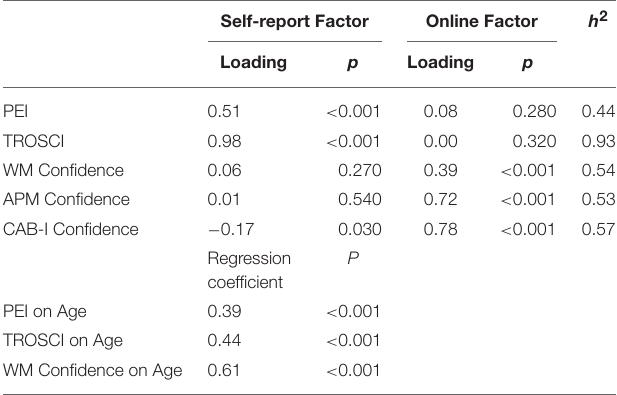
TABLE 3 | Results of two-factor exploratory structural equation model for five self-confidence measures ( N =